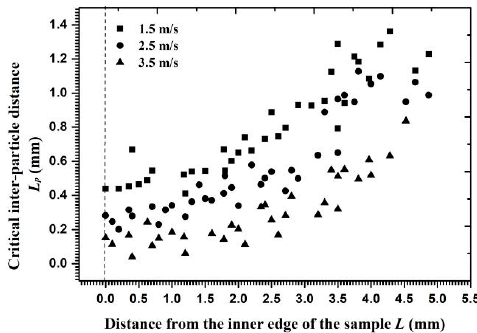
Figure 16. The critical inter-particle distance versus the distance from the inner edge at different flow velocities.